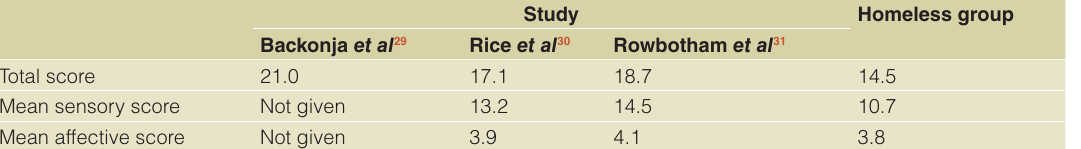
Table 3. Comparison of mean short-form McGill pain questionnaire (SF-MPQ) scores given by homeless participants with those given by volunteers with neuropathic pain enrolled in studies examining anti-neuropathic